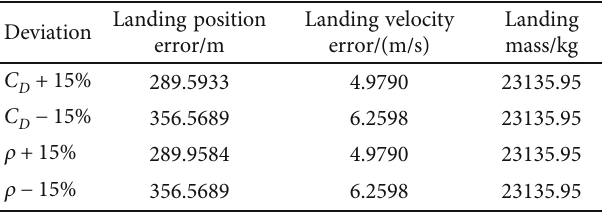
Table 7: Landing errors and masses of the trajectory optimization algorithm.